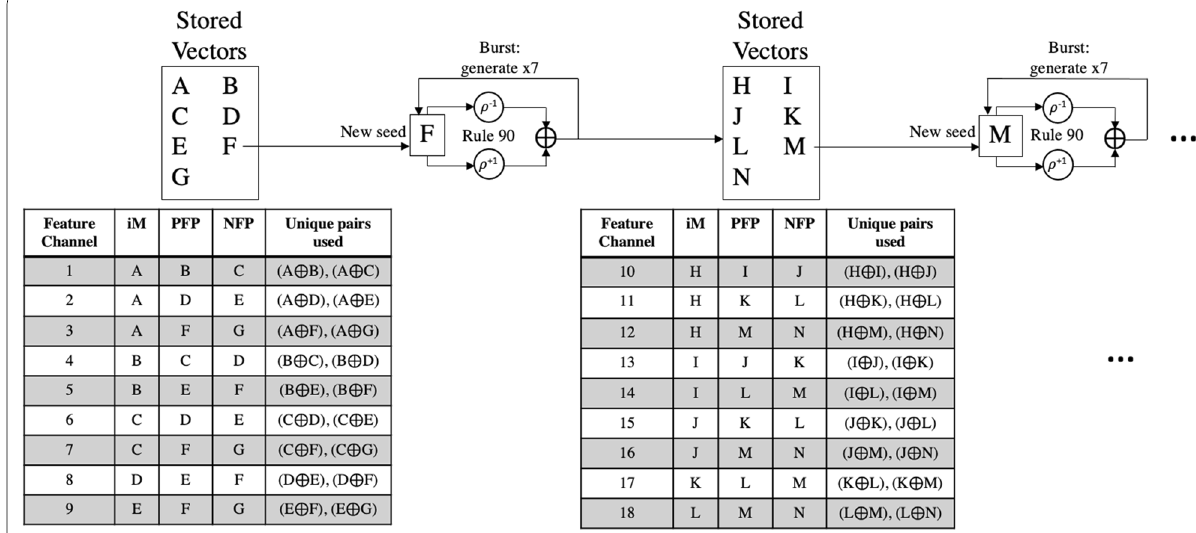
Fig. 5 ‘Combinatorial pairs’ feature channel vector set generation demonstrated for 7 stored vectors. iM loops through vector bank after exhausting available sequential pairs for FP. Hybrid method follows by burst re-generating the vector bank with rule 90 so that new combinatorial pairs can be formed for more feature channels. Generation of 18 feature channel vector sets using a bank of only 7 vectors is